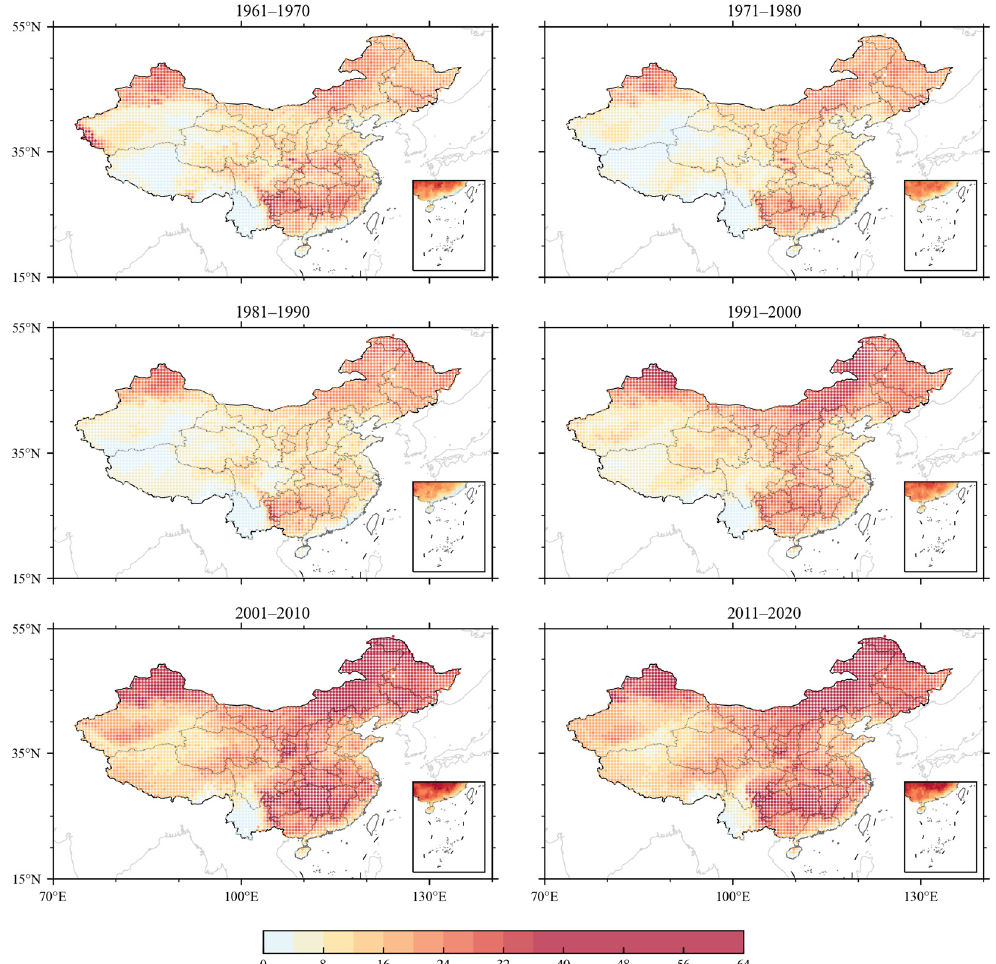
Figure 10. Distribution diagram of decadal average duration days of heat waves based on FATM.